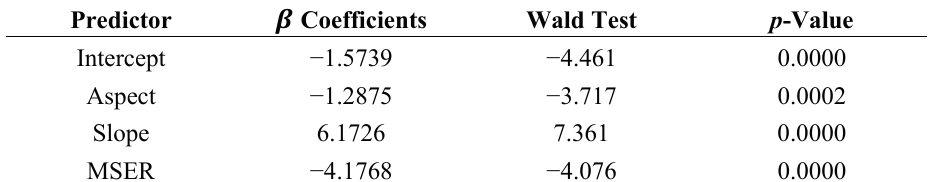
Table 7. (cid:2010) coefficients, Wald test and p -values for the